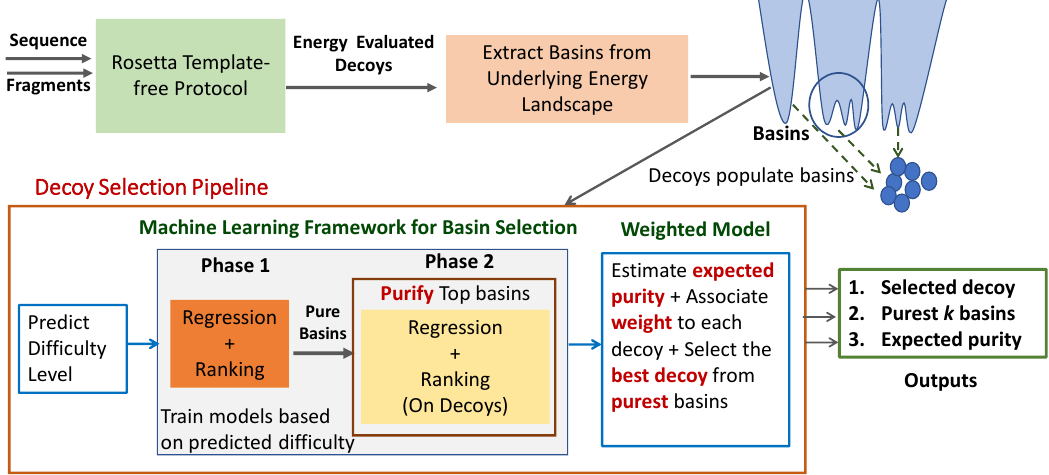
Figure 1. Illustration: Pipeline of ML-Select followed by a weighted model to first select pure basins and then select an individual decoy for